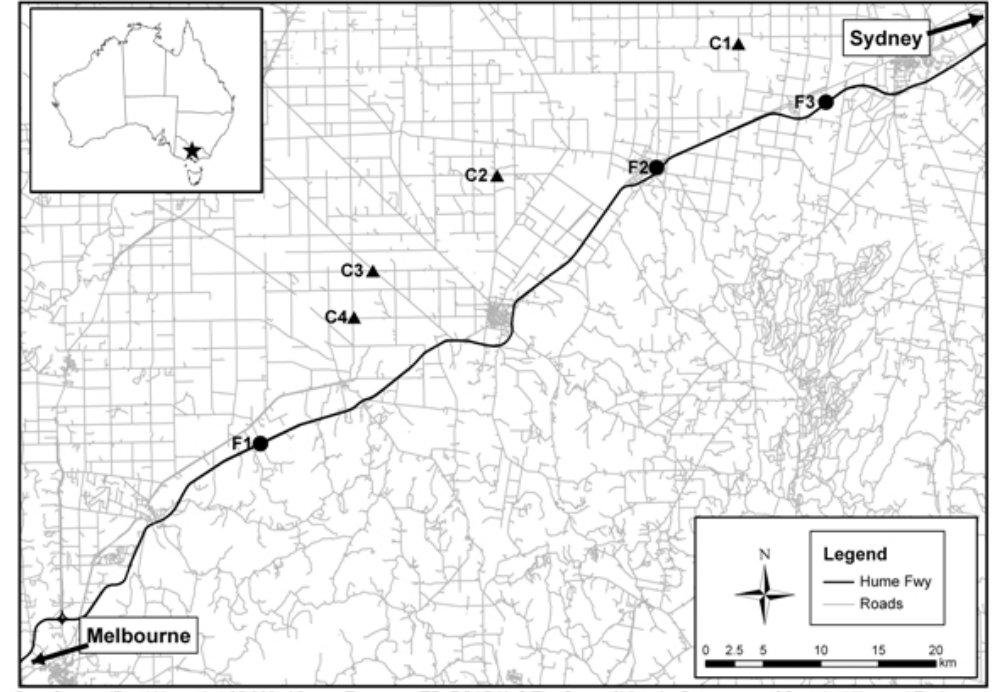
Fig. 1 . Location of sample populations of squirrel gliders ( Petaurus norfolcensis ) in southeast Australia: C1 C2, C3, and C4 refer to control populations; F1, F2, and F3 refer to freeway